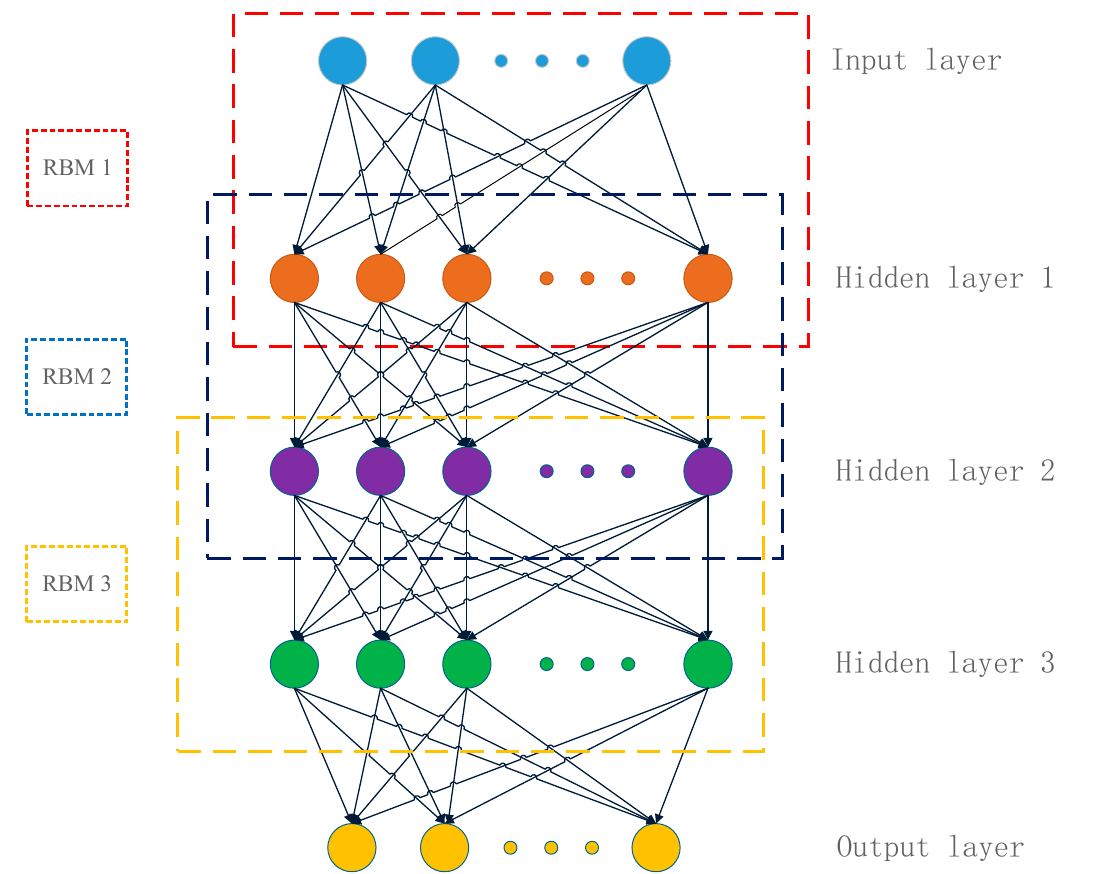
Figure 2. Illustration of a typical deep belief network (DBN).